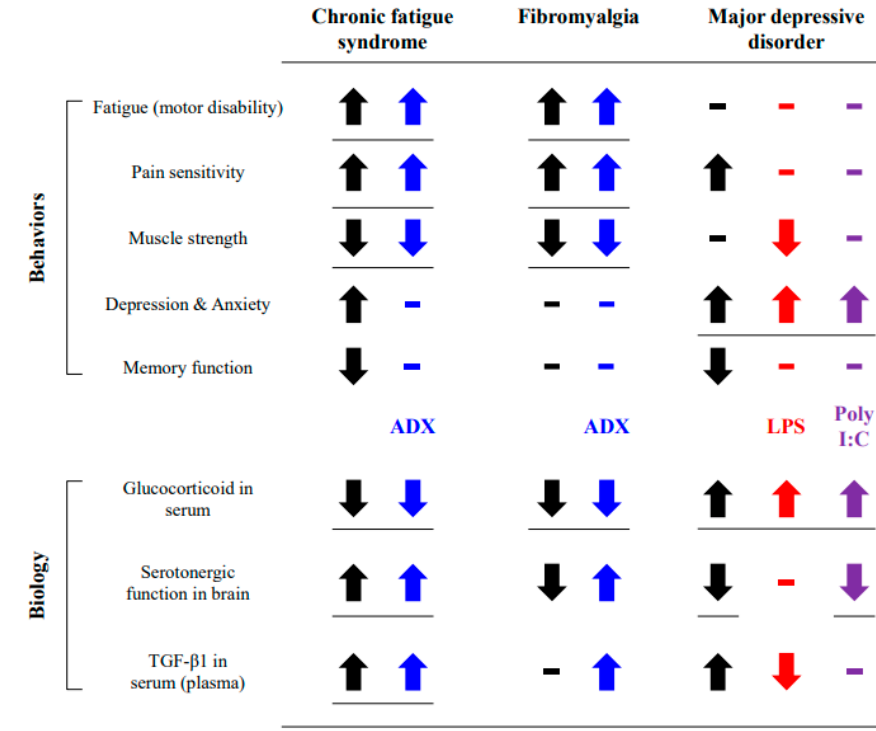
Figure 6. Summary of results. The obtained results were compared to the behavioral and biological features of CFS or similar diseases.